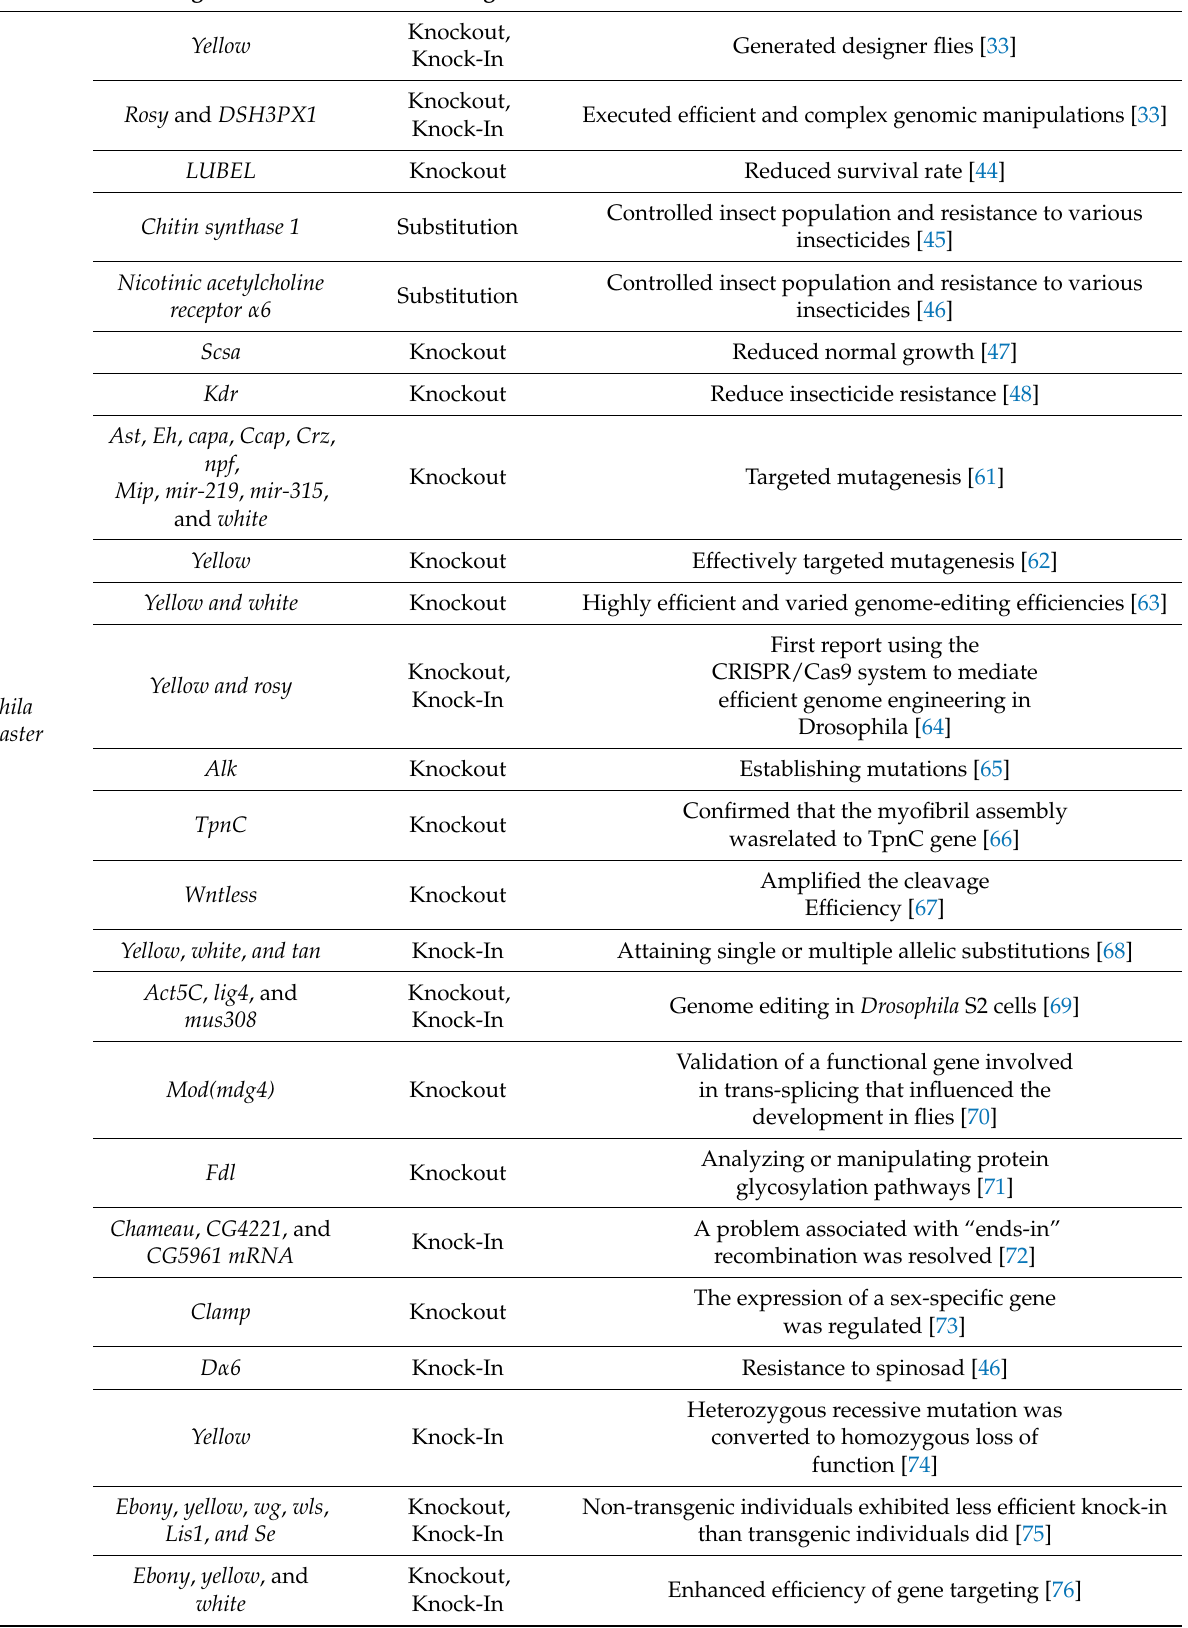
Table 1. CRISPR-Cas genome editing in insects for insect pest